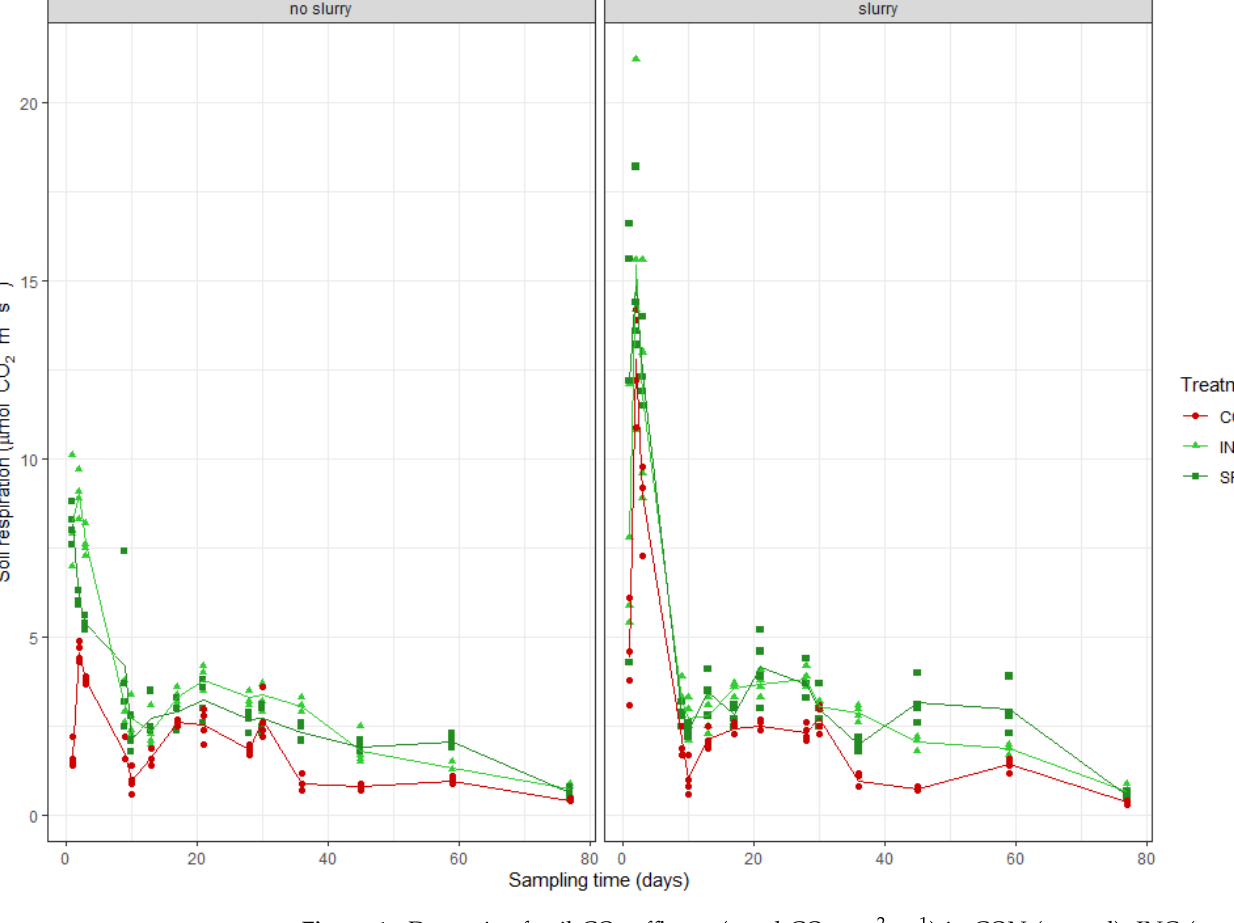
Figure 1. Dynamic of soil CO 2 effluxes (µmol CO 2 m −2 s −1 ) in CON (control), INC (straw incorporated in 0–10 cm soil layer) and SRF (straw applied at the soil surface) soil treatments in presence/absence of slurry (S). Averages and standard errors of 4 replicates are shown.